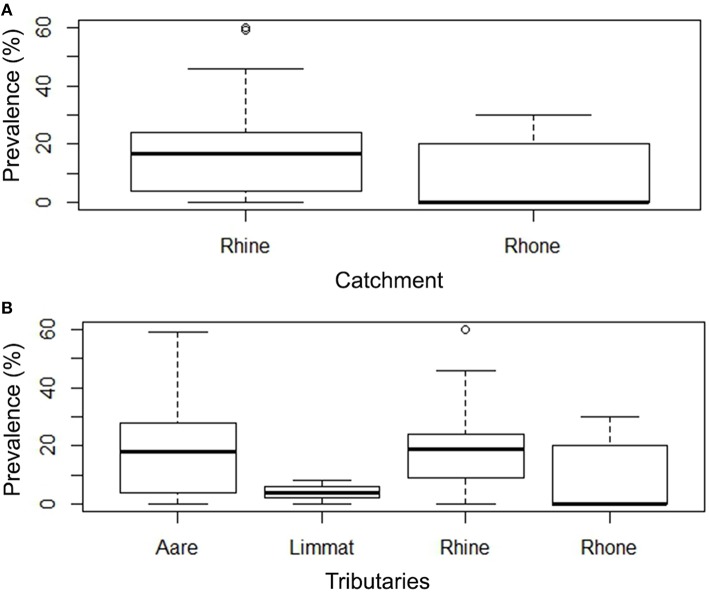
(A) Box Plot of the prevalence (%) of EP in Rhine and Rhone catchments. There is a higher probability of finding infected animals in the Rhine catchment compared to the Rhone catchment (Two-level Logistic Regression model, p < 0.000000). (B) Prevalence of infected animals in tributaries (Aare, Limmat, and Rhine belonging to the Rhine catchment; Rhone belonging to the Rhone catchment).